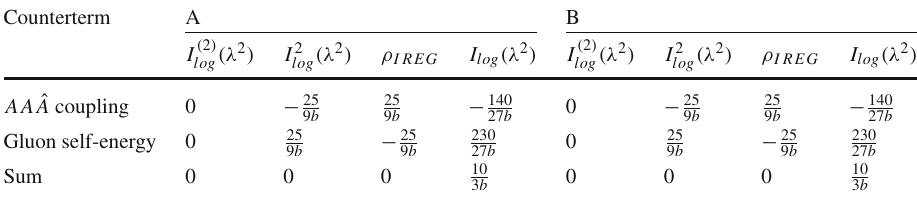
for pure Yang–Mills using IREG where